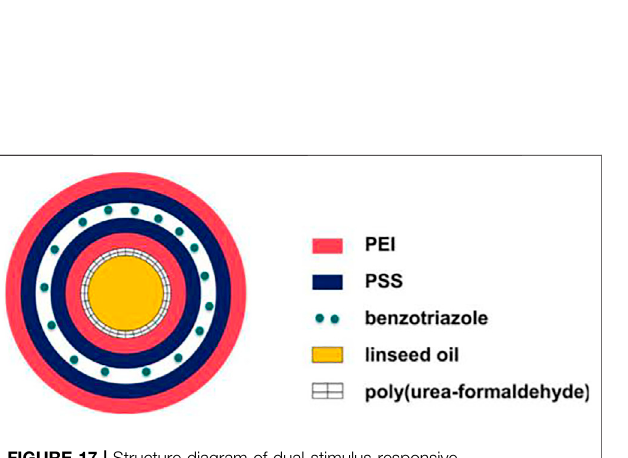
Frontiers in Materials |